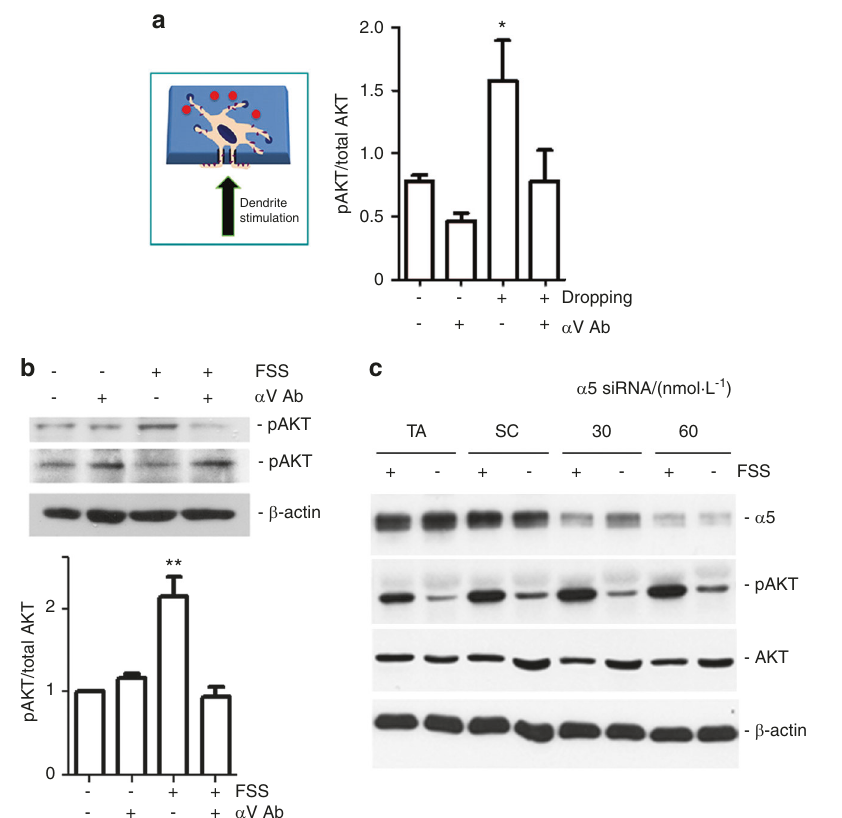
Fig. 3 Integrin α V is required for PI3K-AKT activation induced by mechanical stress. a Inhibition of integrin α V prevents AKT activation induced by mechanical dropping on dendritic processes. MLO-Y4 cells cultured on transwell fi lter inserts were preincubated with an antibody blocking α V activation ( α V Ab) for 20 min and mechanically stimulated by solution dropping on the dendritic process side of the transwell fi lter. The fi xed cells were immunolabeled with an anti-phospho-AKT (Ser473) (pAKT) or total AKT antibody. The fl uorescence intensities of pAKT and total AKT were quanti fi ed, and their ratio was calculated. Cells stimulated by dropping only versus all other treatments, *, P < 0.05. b Inhibition of integrin α V prevents AKT activation induced by FSS. MLO-Y4 cells were subjected to FSS for 30 min, and cell lysates were immunoblotted with an anti-pAKT or total AKT antibody (upper panel). The intensities of the protein bands were quanti fi ed, and the ratio was calculated and normalized to resting conditions (lower panel). Cells stimulated by FSS only versus all other treatments, **, P < 0.01. The data are presented as the mean ± SEM. n = 3. c Knocking down integrin α 5 has no effect on AKT activation induced by FSS. MLO-Y4 cells were pretreated with 30 or 60 nmol·L − 1 α 5 siRNA, scrambled RNA (SC) or vehicle control (TA) for 48 h and then subjected to FSS for 30 min. Cell lysates were immunoblotted with an anti- α 5, pAKT, AKT, or β -actin